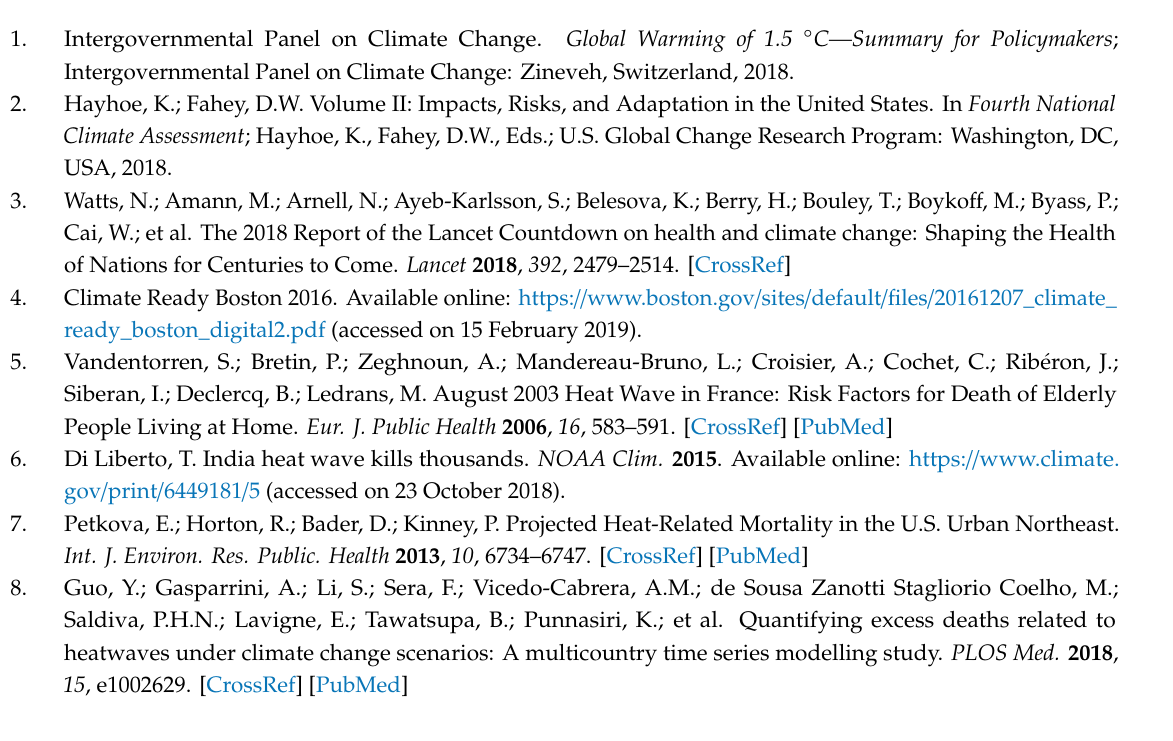
Figure S1: Satisfaction and perception of indoor thermal conditions at the baseline of the study period, Figure S2: Percent of respondents indicating their perception of the temperature of their apartment during the study period. Table S1: Baseline survey used to assess personal demographics, sleeping habits, perception / satisfaction with IEQ, and pre-existing demographics, Table S2: Daily survey used to assess the previous day’s activities, IEQ, sleep quality, adaptive behaviors, health symptoms, Table S3: Generalized logistic mixed e ff ect regression output Odds Ratios (OR) for any health symptom or heat-related health symptoms adjusting for daily mean indoor temperature and having at least 2 preexisting conditions (model 1) or and having a personal heat action plan (model 2), with participant as a random e ff ect, Table S4: Generalized logistic mixed e ff ect regression